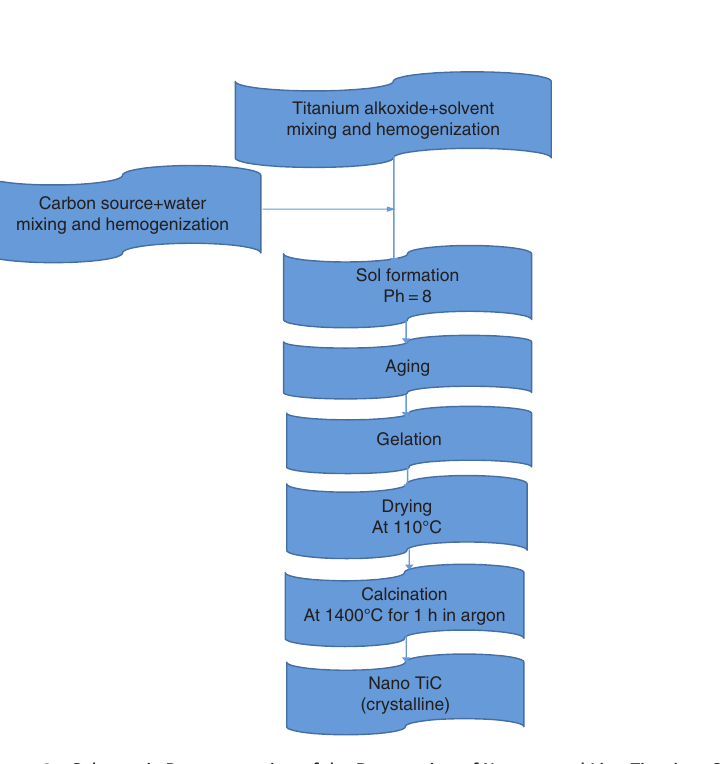
Figure 3: Schematic Representation of the Preparation of Nanocrystal Line Titanium Carbide Powders by Sol–Gel